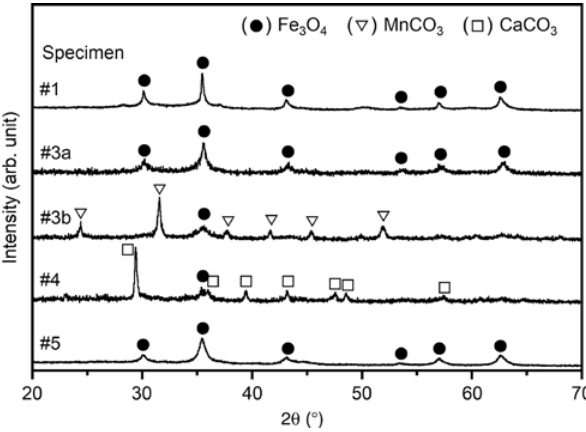
Figure 2: XRD patterns of the products after high-energy ball